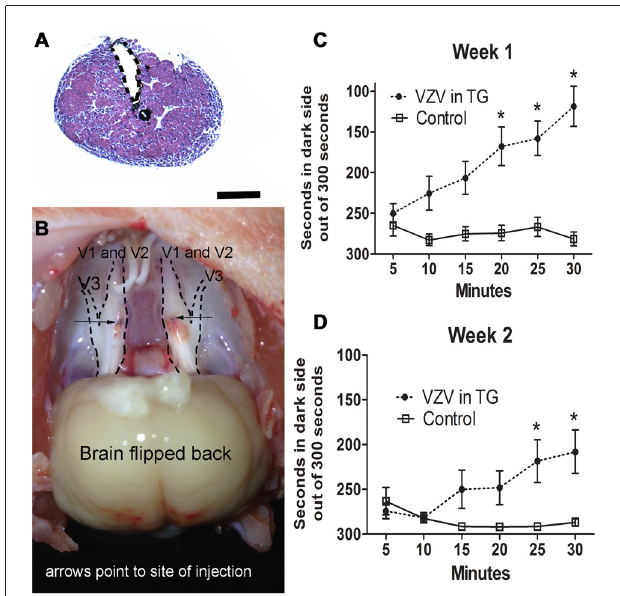
FIGURE 1 | Experiment 1, the affective pain increased after injection of varicella zoster virus (VZV) into the trigeminal ganglion. (A) shows a hematoxylin eosin stained coronal section of the trigeminal ganglion after stereotaxic injection of India ink (black). The needle injection site is marked by a dotted line. Bar = 1 mm. In (B) a gross dissection of a rat head is shown with the trigeminal ganglion exposed after bilateral stereotaxic injection with India ink (arrows point to the black India ink spots). V1, V2 and V3 refer to the different branches of the trigeminal ganglion. Place escape avoidance paradigm (PEAP) behavioral measurements were completed weekly, (C) is 1 week after VZV was injected into the trigeminal ganglion and (D) is the second week after VZV was injected into the trigeminal ganglion. Asterisk indicates a significant difference of p < 0.05. The values are the mean ± standard error of the mean (SEM). There were 11 animals in the control group and 17 animals in the VZV treatment group.